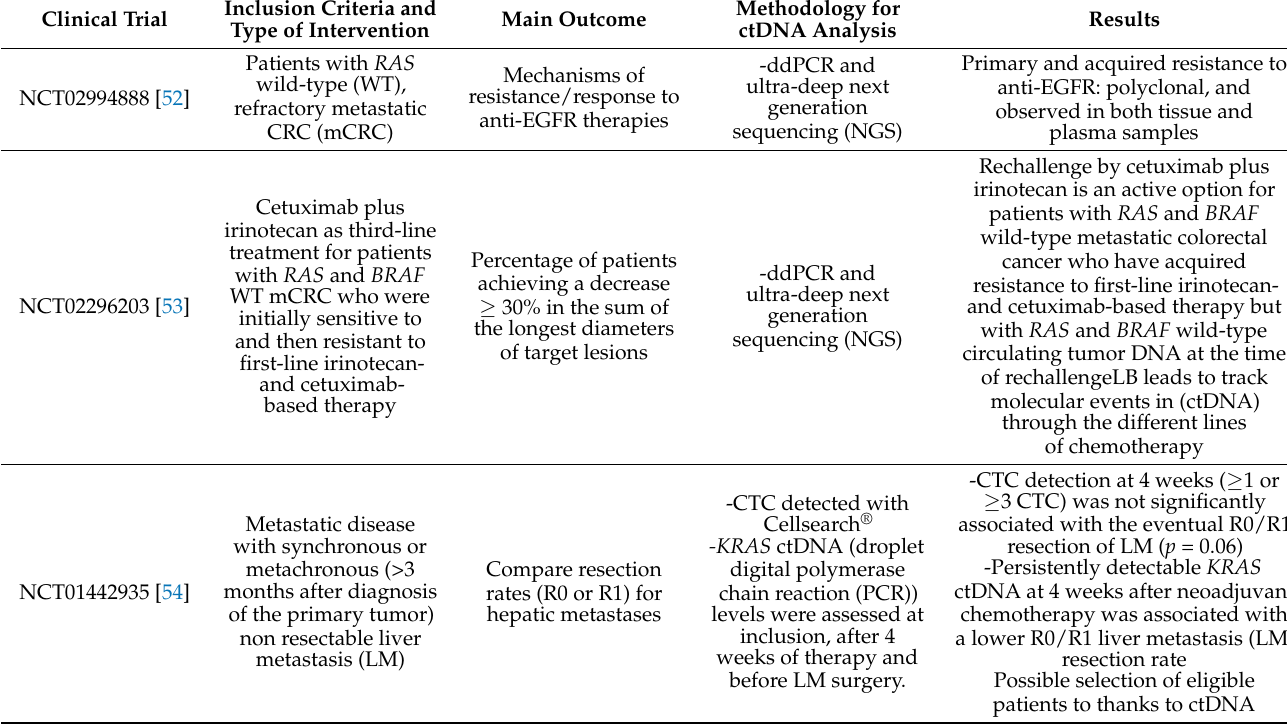
Table 2. Liquid biopsy and personalization of colorectal cancer treatment in Randmomized controlled trials (RCTs). Inclusion Criteria and Clinical Trial Type of